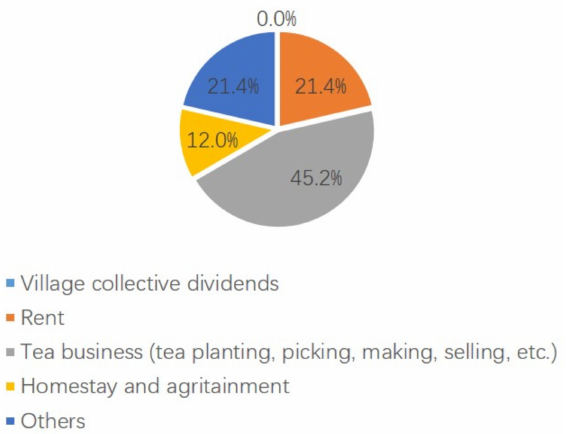
Figure 14. Reasons for the increase in respondents’ household monthly income under the CT practice (WLLTT) (source: authors).